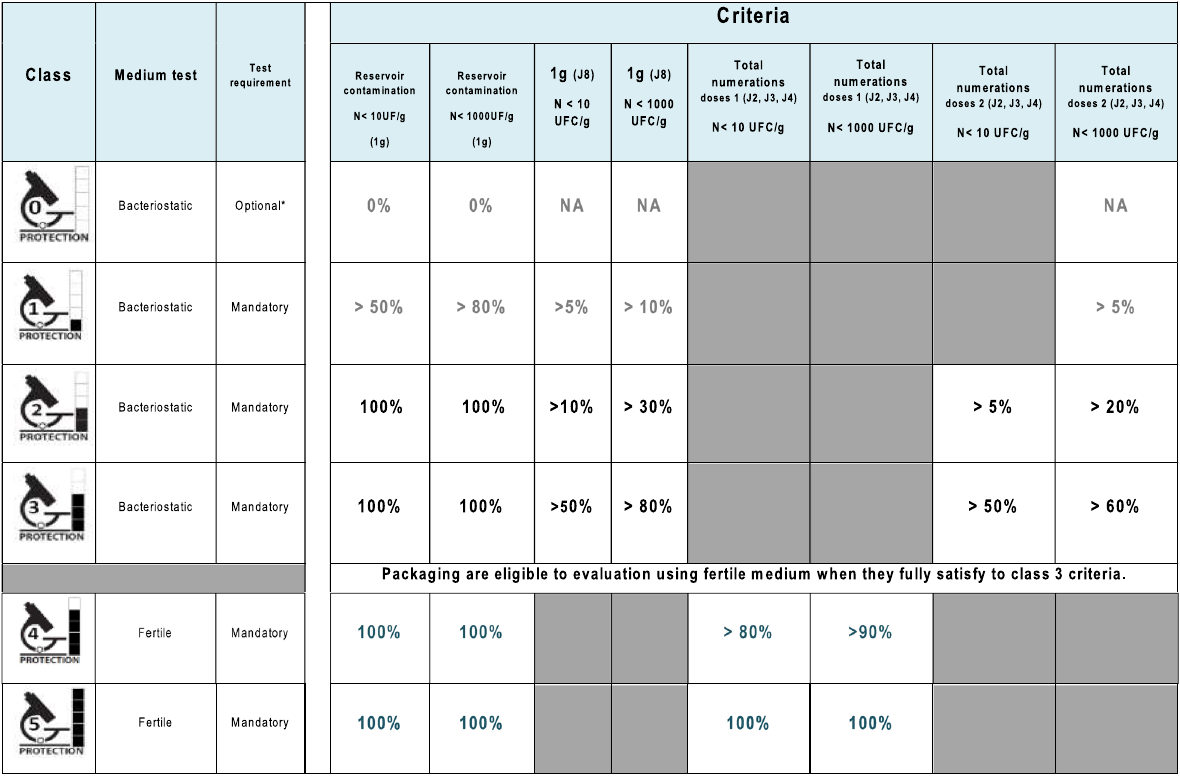
Table 4 Classification of the packs in regard of their microbiological protection properties and criteria of each class established on the basis of in-use